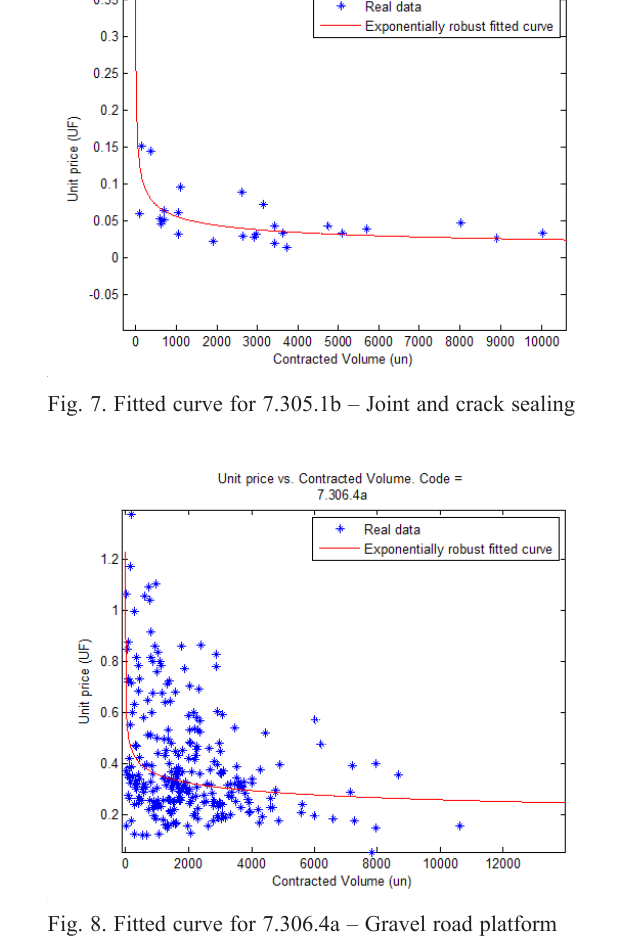
Fig. 8. Fitted curve for 7.306.4a – Gravel road platform